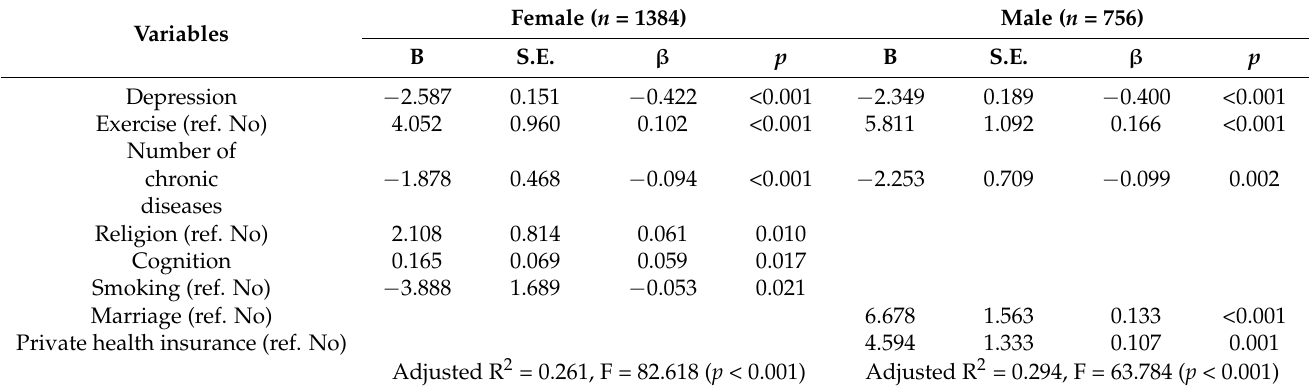
Table 4. Factors affecting life satisfaction with overall quality of life by gender ( n =